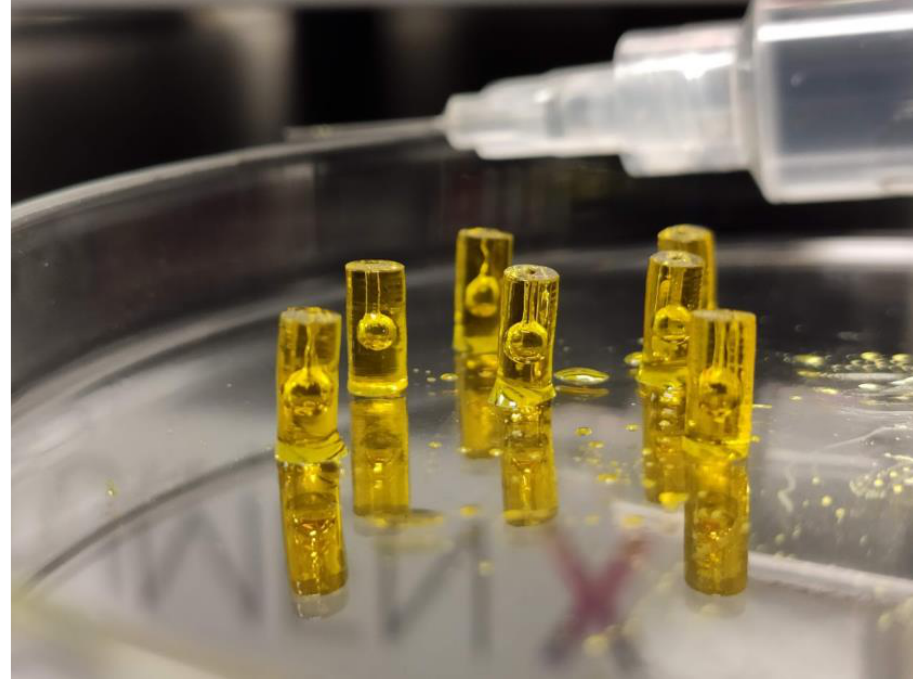
Figure 5. One set of printed spinal cords after printing and removal of uncured material. aCSF is